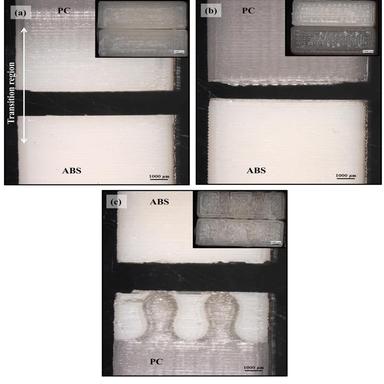
Fractured specimens after tensile testing (a) gradient transition (b) fractured surface of direct transition (c) interlock pattern.